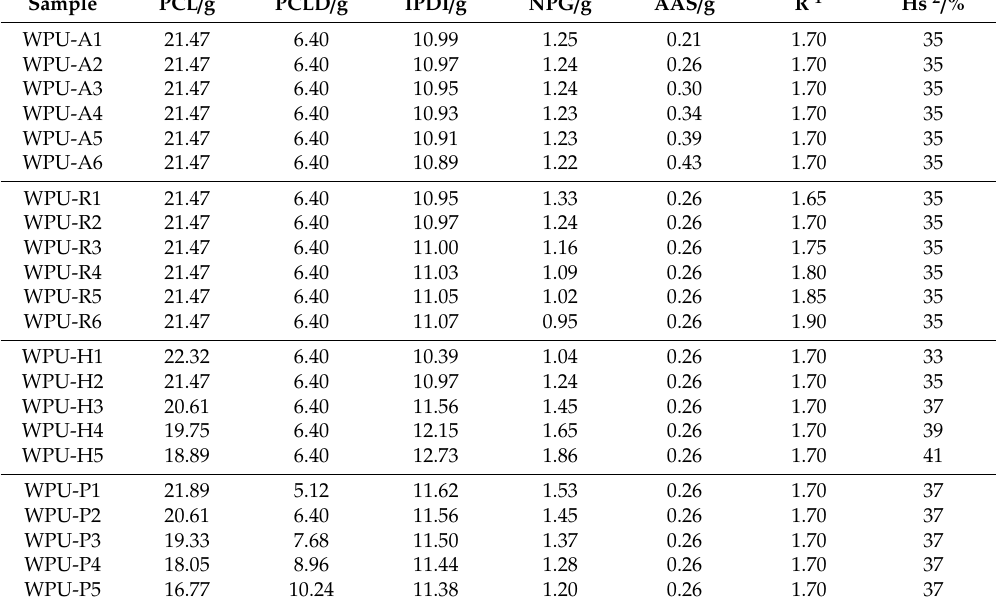
Table 1. The main compositions of prepared waterborne